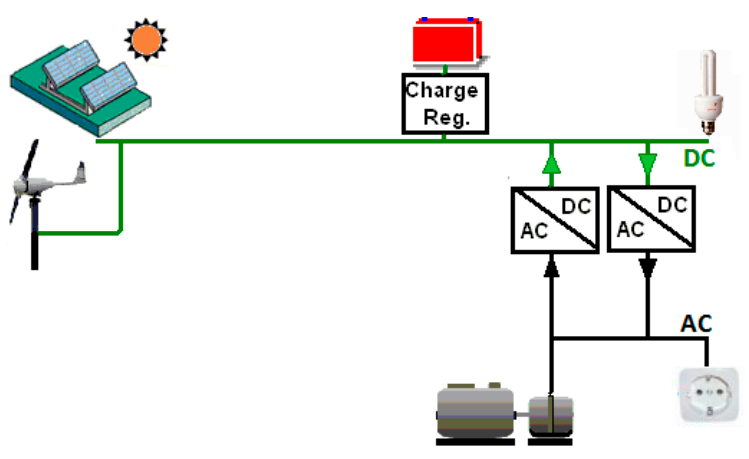
Figure 8. Energy sources used for iHOGA with DG.